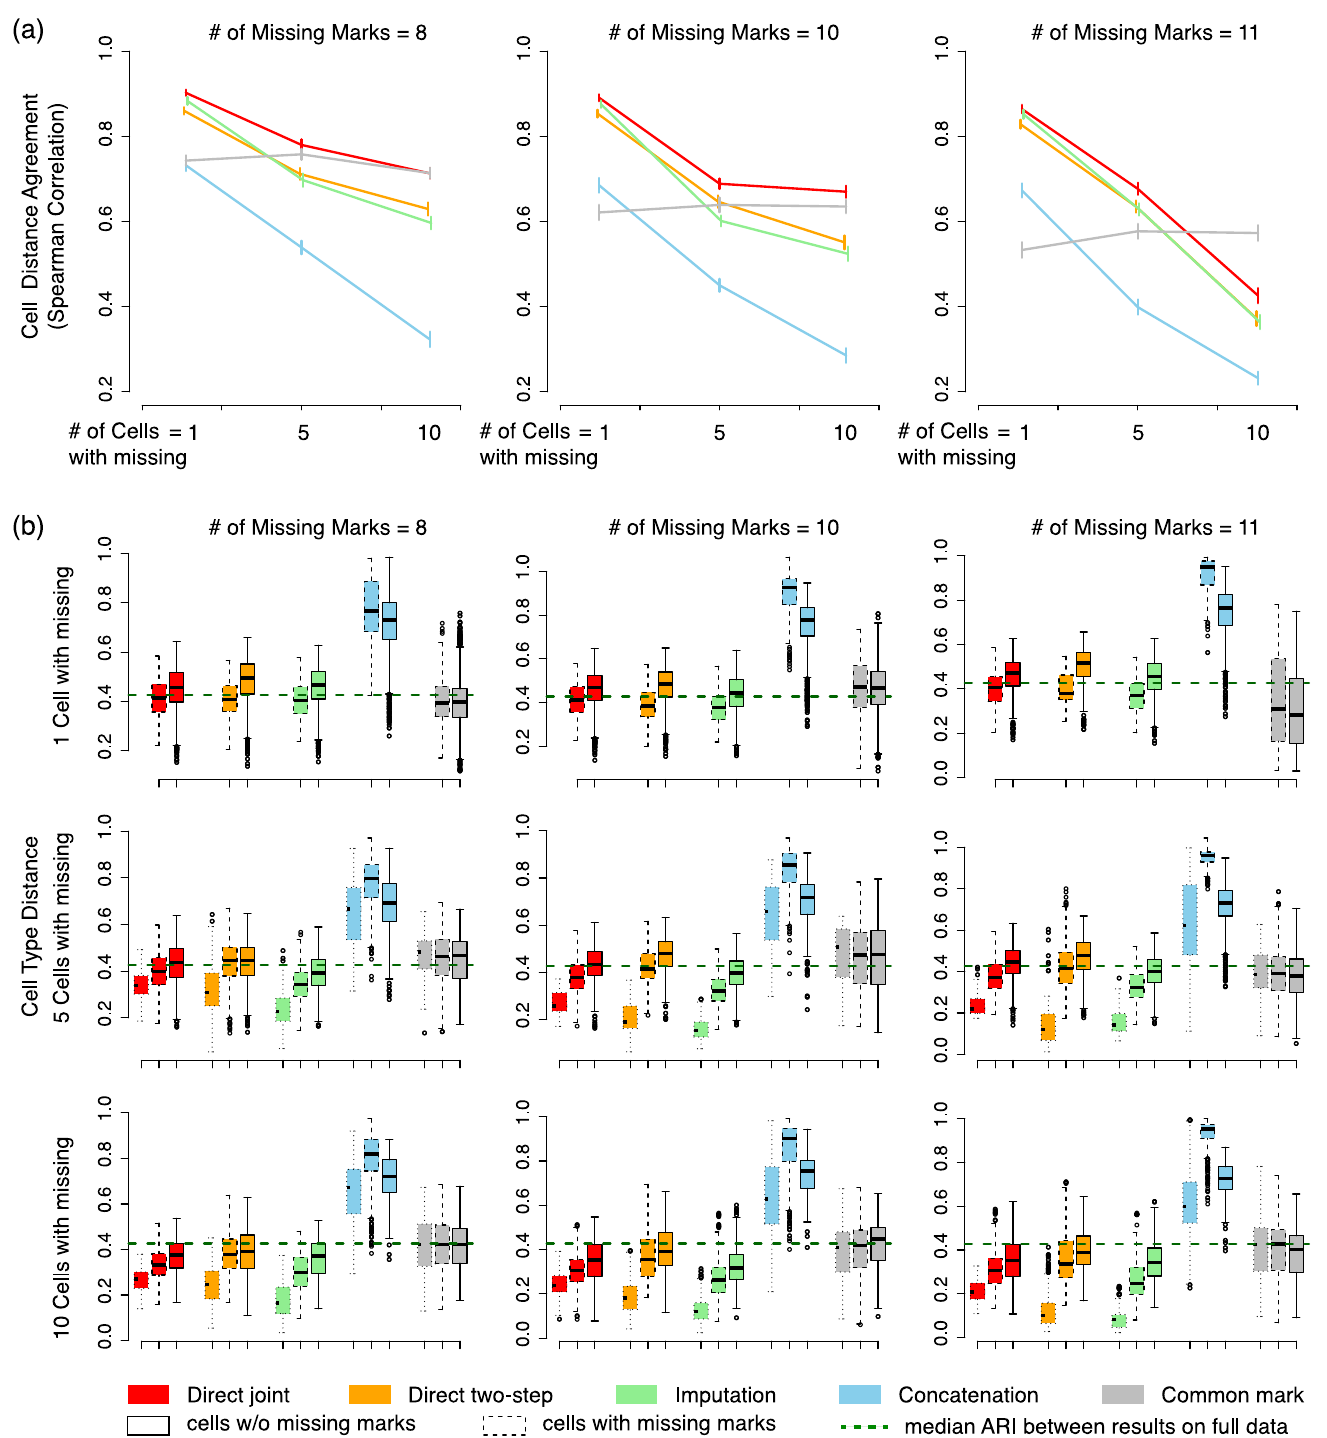
Fig 3. Comparison of segmentation-derived cell type relationships. (a) Concordance of cell type distances inferred from partial data by different methods compared with the distances inferred from full data segmentation. Concordance is measured by Spearman correlation between two distance vectors for each cell type. Red: joint segmentation; orange: two-step segmentation; green: imputation; blue: concatenation; grey: common mark. (b) Distribution of segmentation-based distances between